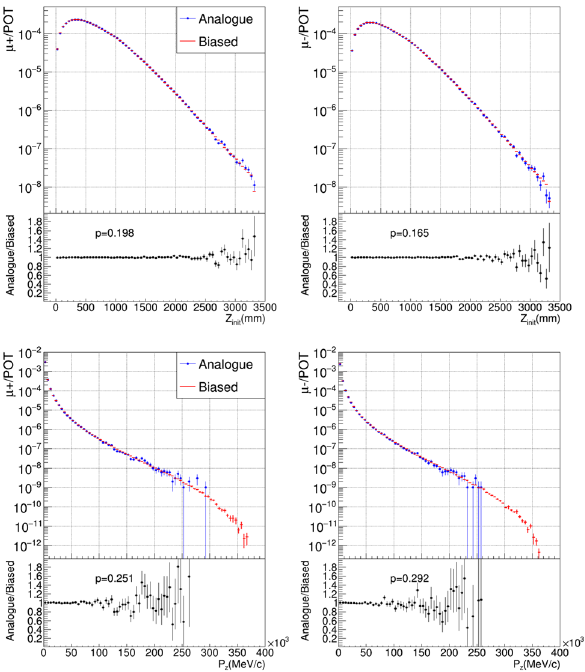
Fig. 2 z -coordinate of muon emission (top) and z -component of muon momentumatthescoringplane(bottom)intheanalogue(symbols,blue) and biased (continuous, red) samples with positive particles plotted on the left column and negative ones on the right column. Ratio plots, together with the p value from the χ 2 test for the analogue and biased distributions, are also shown